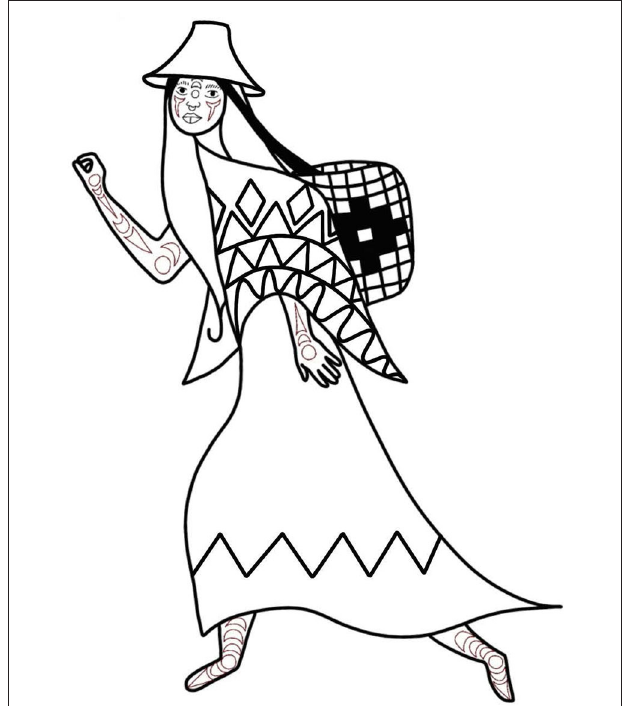
FIGURE 6 | Indigenous harvester drawn by artist Ocean Hyland from the Tsleil waututh and Squamish Nations. This illustration celebrates the beauty of harvesting and depicts the harvester with a Coast Salish woven blanket and harvesting basket.